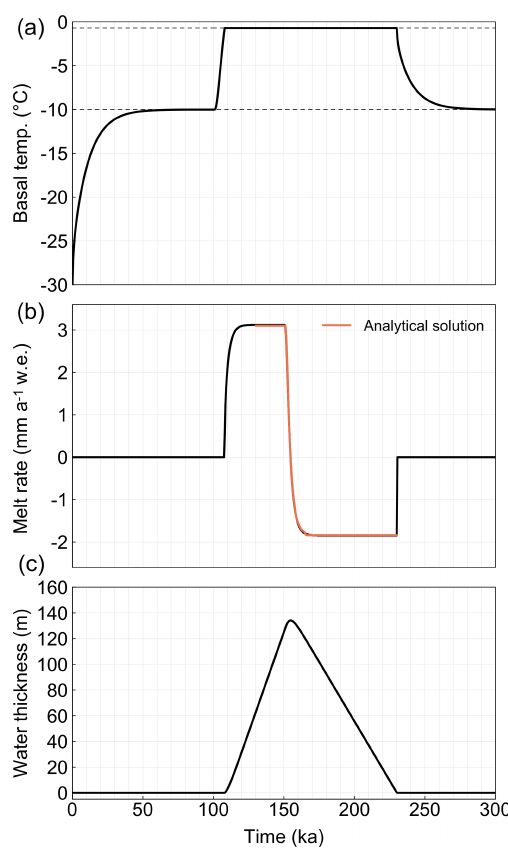
Figure 5. Time series of the (a) basal temperature, (b) basal melt rate and (c) basal water layer corresponding to the thermodynamic benchmark experiment Exp. A (Kleiner et al., 2015). The analytical solution (thick, light-red line) for the basal melt rate is compared to Yelmo results (black lines). Not that where the Yelmo results are not visible, they overlap with the analytical